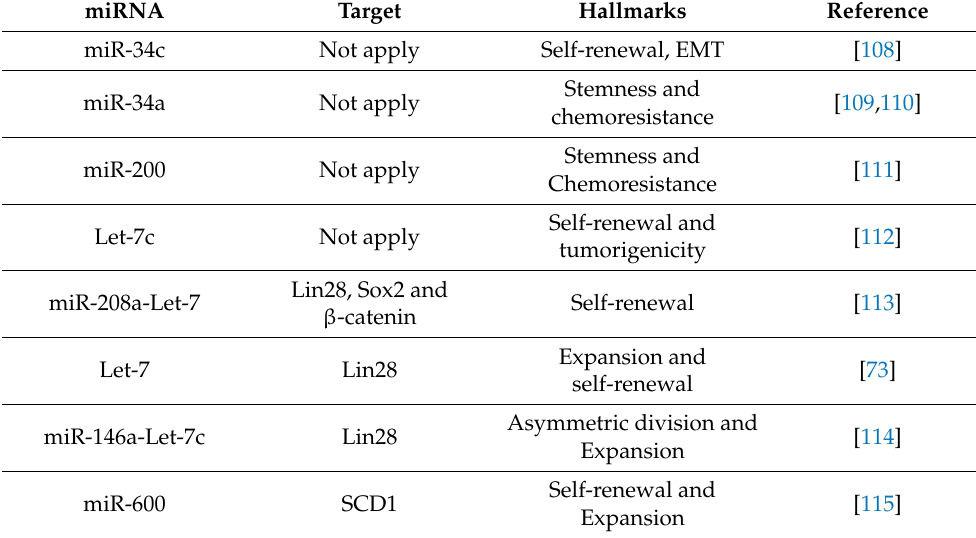
Table 2. MiRNAs implicate in the bCSC biology.